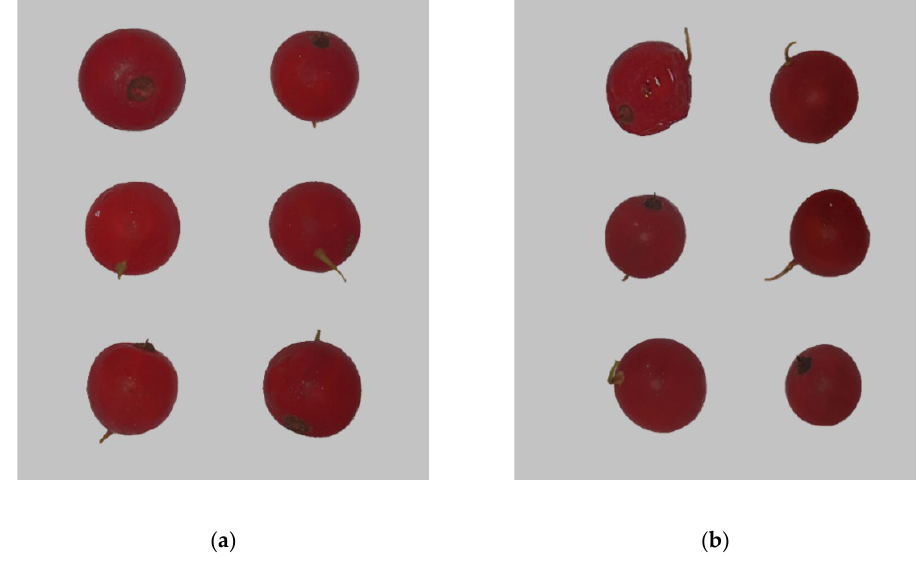
Figure 3. Images of sample red currants stored in the refrigerator for one week ( a ) and two weeks ( b ). Red currant images were processed using the MaZda software (Ł ó d´z University of Technology, Institute of Electronics, Ł ó d´z, Poland) [29–31]. Before image processing, the background of the images was changed to black with an intensity of 0. This step was performed to facilitate the segmentation of the images into fruit and background and the determination of the regions of interest (ROIs). The file format of images was changed to BMP. Then, images were converted to different color channels R , G , B , L , a , b , X , Y , and Z using MaZda. Color channels R (red), G (green), and B (blue) belonged to the RGB color space, color channels L (lightness from black to white), a (red for positive values and green for negative), and b (yellow for positive values and blue for negative) were from the Lab color space, and color channels X (a component of color information), Y (lightness), and Z (a component of color information) were from the XYZ color space [32]. The image segmentation into fruit and the background was performed based on the intensity of pixel brightness. The black background had an intensity of 0, whereas each ROI including